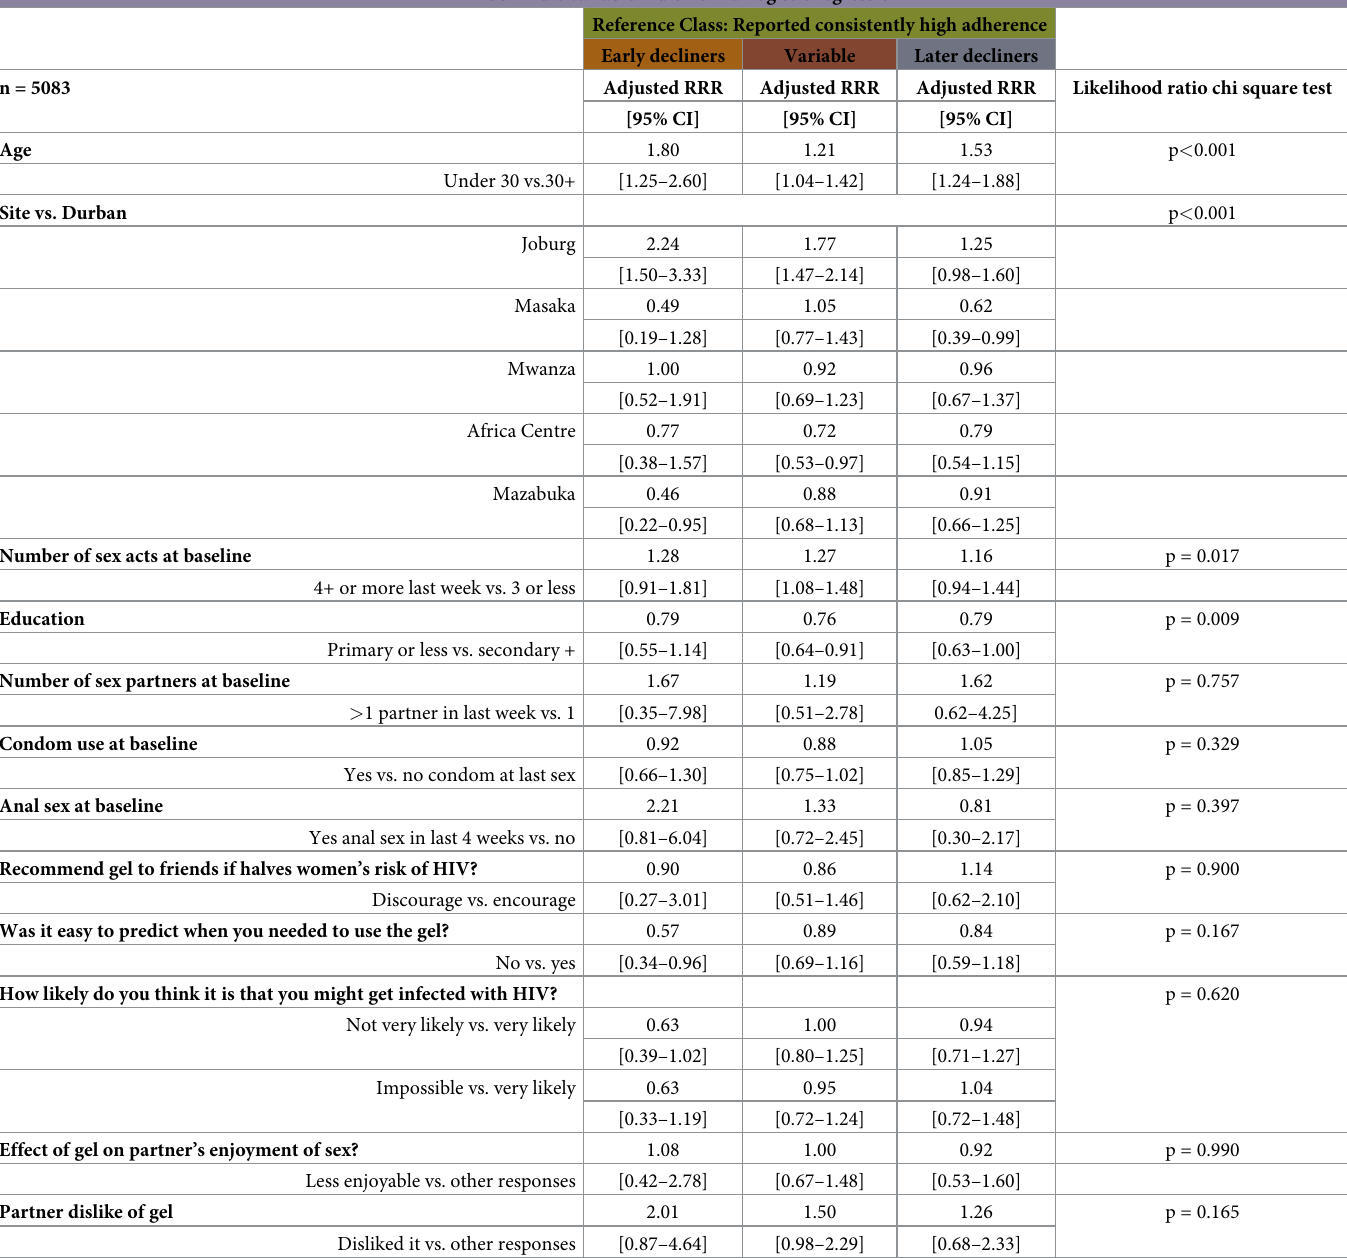
Table 3. MDP 301 multivariable multinomial logistic